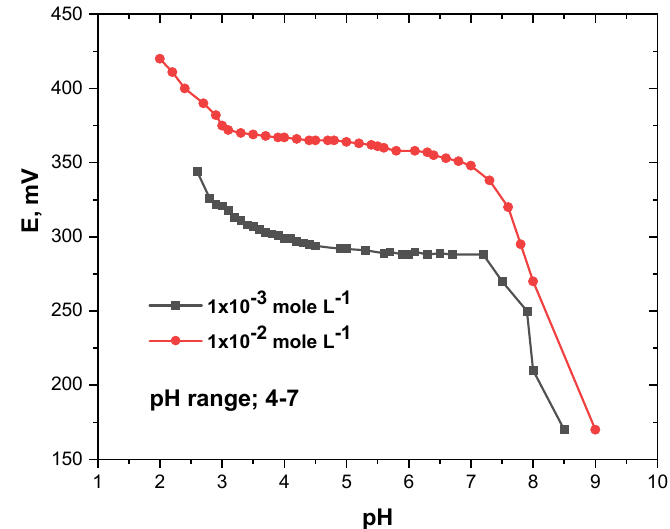
Figure 4. Influence of the pH on the response of the MIP-based MB microchip.